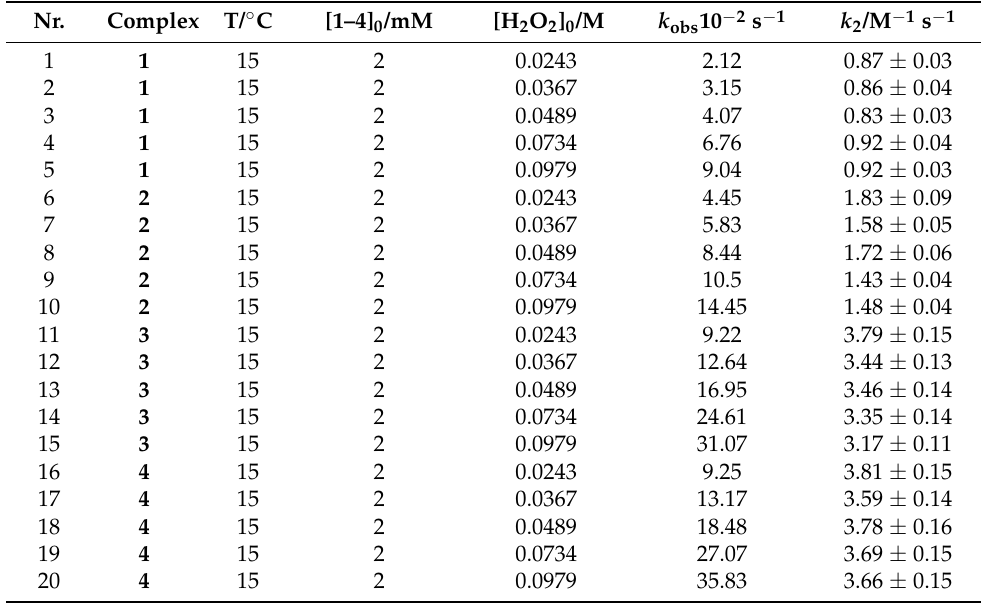
Table 2. Kinetic data for the formation of intermediates 5 , 6 , 7 and 8 in CH 3 CN.